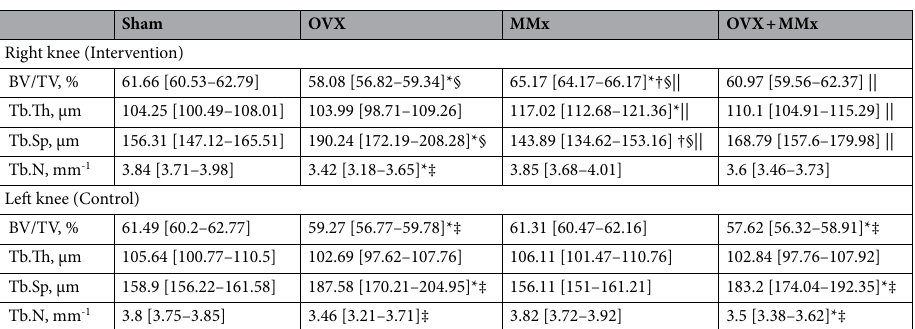
Table 3. Microcomputed tomography evaluation of subchondral bone. Values are presented as the means and 95% CIs. *: p < 0.05 compared with the Sham group; †: p < 0.05 compared with the OVX group; ‡: p < 0.05 compared with the MMx group; §: p < 0.05 compared with the OVX + MMx group; ||: p < 0.05 compared with the left knee.